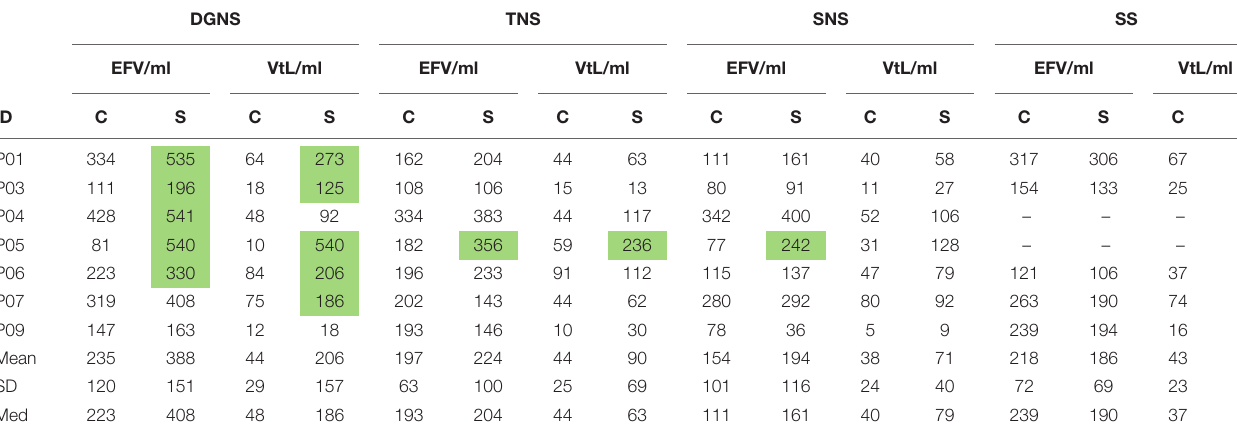
TABLE 3 | Bladder capacity results from baseline and conditional stimulation